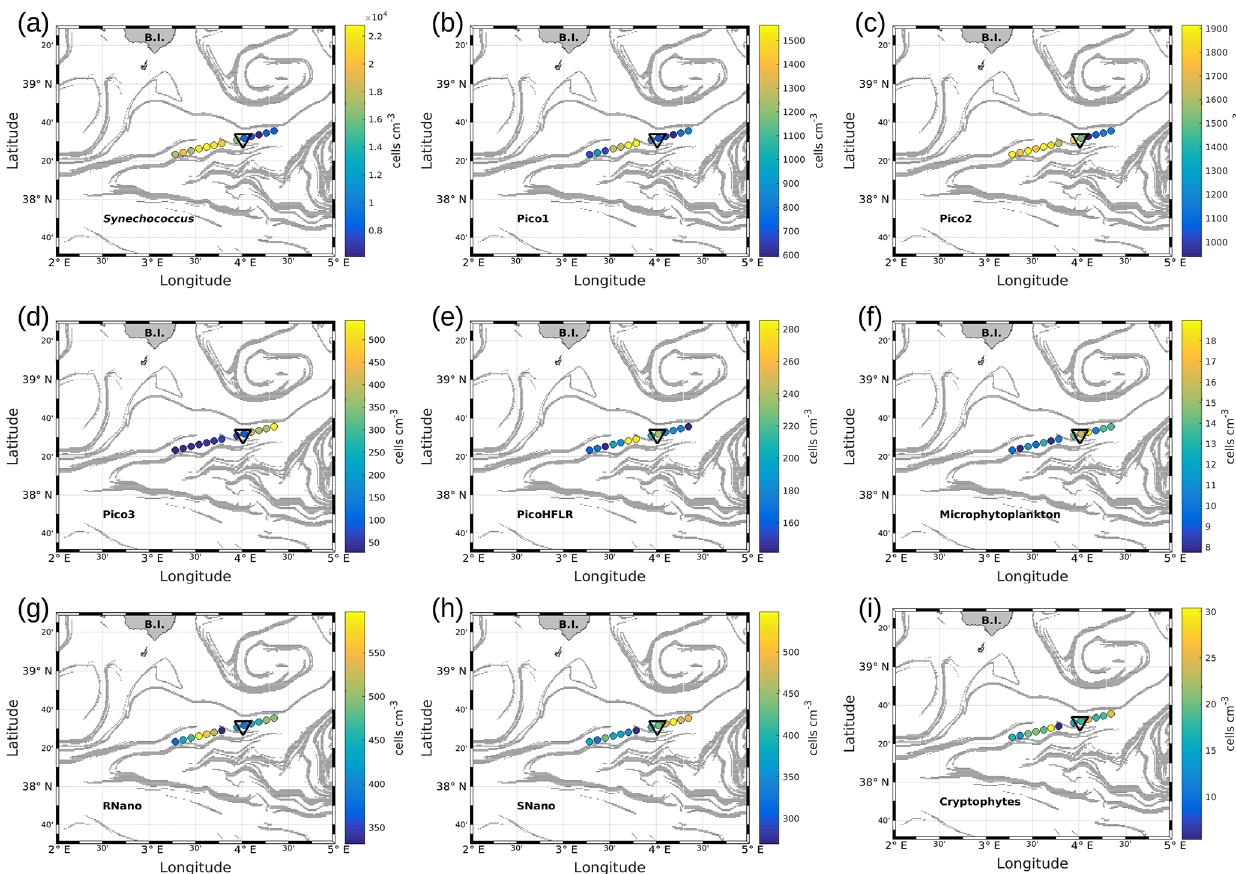
Figure 7. Abundances (in cells per cubic centimeter) of the phytoplankton groups along the WE transect, superimposed upon the FSLE field. Triangles indicate the front area. (a) Synechococcus , (b) Pico1, (c) Pico2, (d) Pico3, (e) PicoHFLR, (f) microphytoplankton, (g) RNano, (h) SNano and (i)